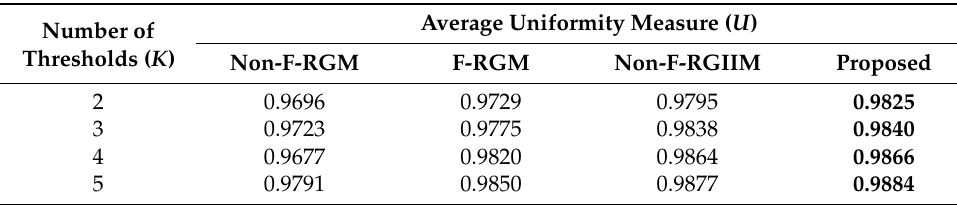
Table 4. Ablation experimental results.